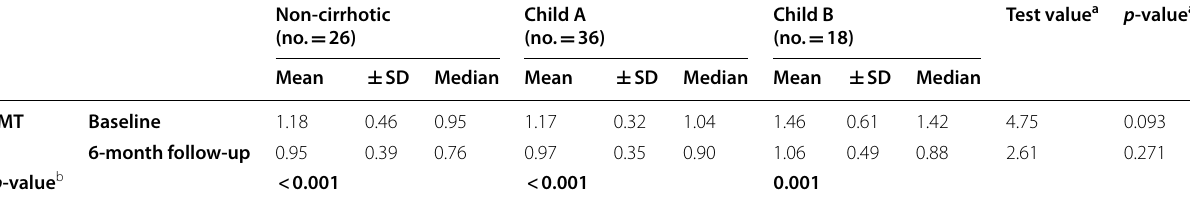
p 0.05 is considered statistically significant; p 0.01 is considered highly statistically significant. a Mann-Whitney U -test. b Wilcoxon signed-rank test. SD Standard ≤ ≤ deviation, IMT Intima-media thickness. No significant difference between cases treated by double SOF/DAC therapy and cases treated by triple SOF/DAC/RBV therapy as regards carotid IMT at baseline and after 6-month follow-up. Meanwhile, there was significant decrease in carotid IMT at baseline compared to after 6-month follow-up in both double and triple therapies